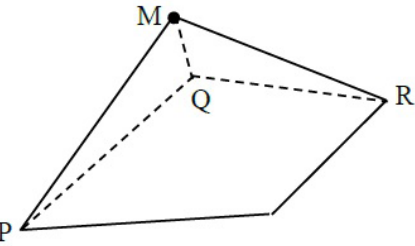
Figure 18: Duplicate edges are dead.